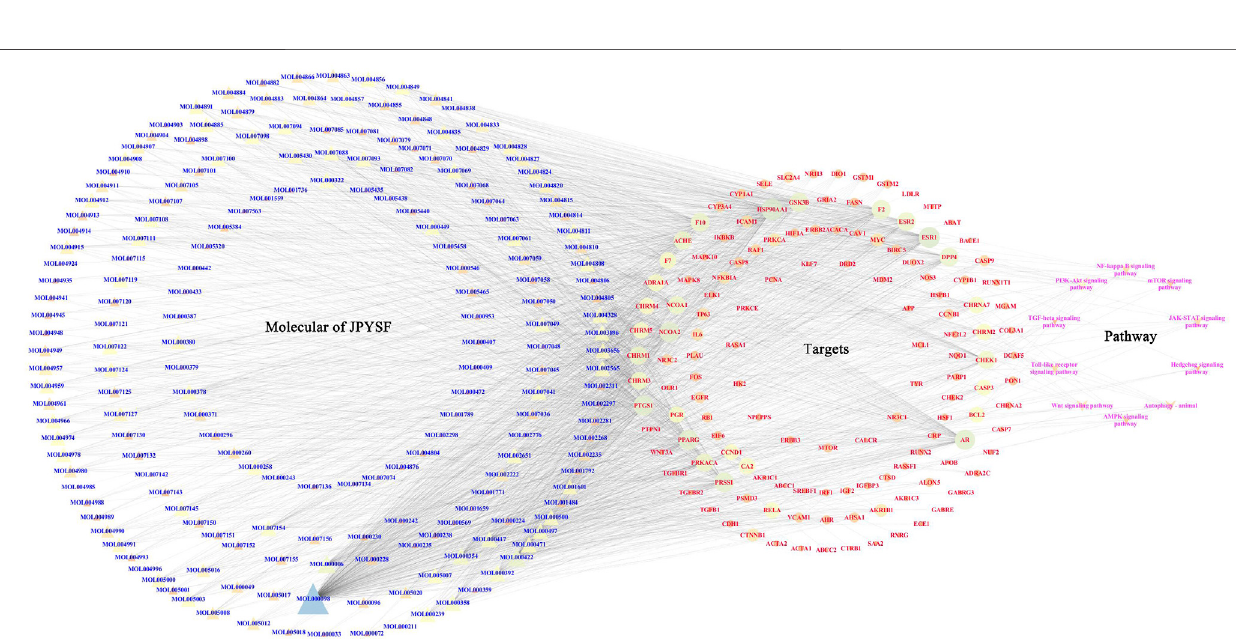
Frontiers in Pharmacology |